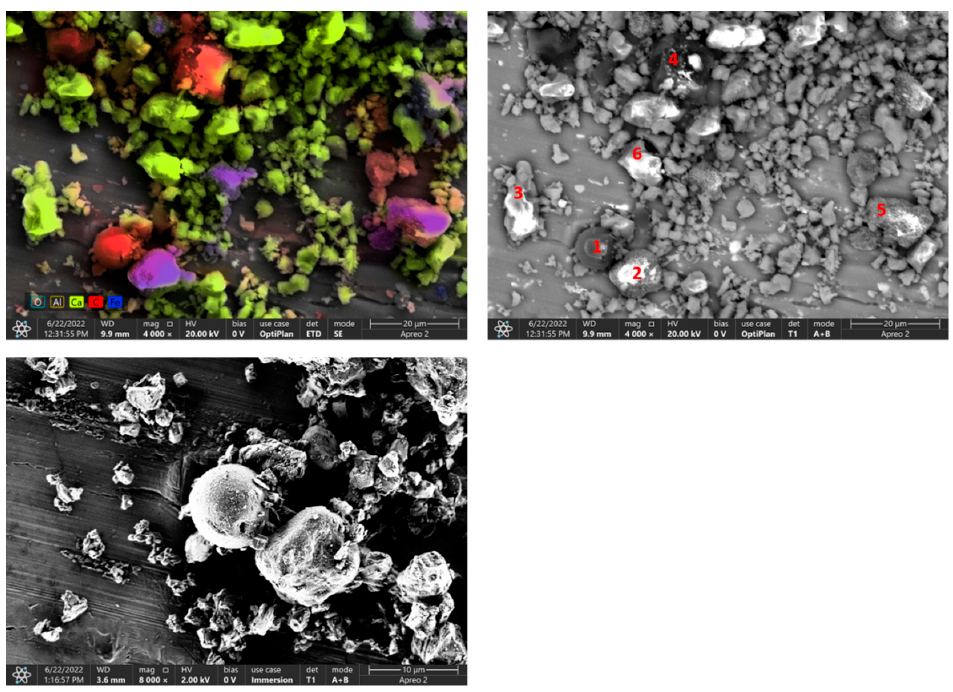
Figure 6. SEM-photographs and EDS analysis of sample C of calcite contaminated with waste toner powder (red numbers mark EDS analysis points). Table 4. Results of EDS analysis of sample C.